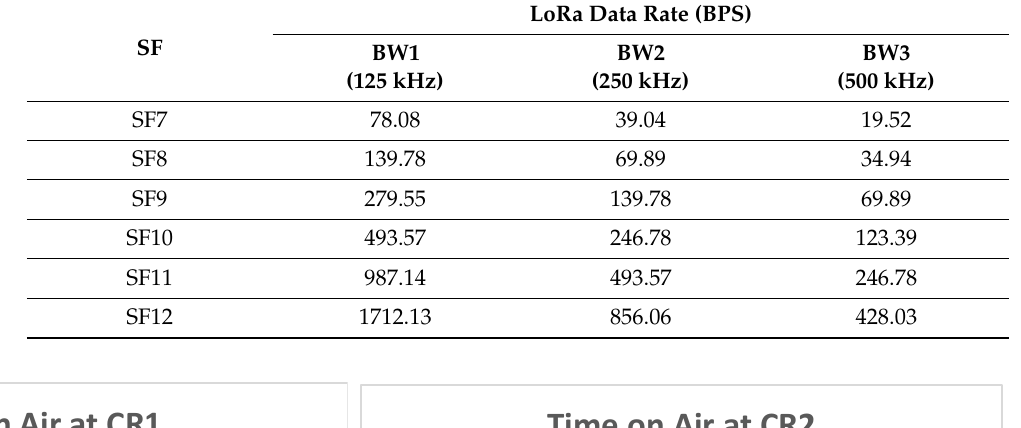
Table 13. Time on air (ToA) (ms) at CR4.